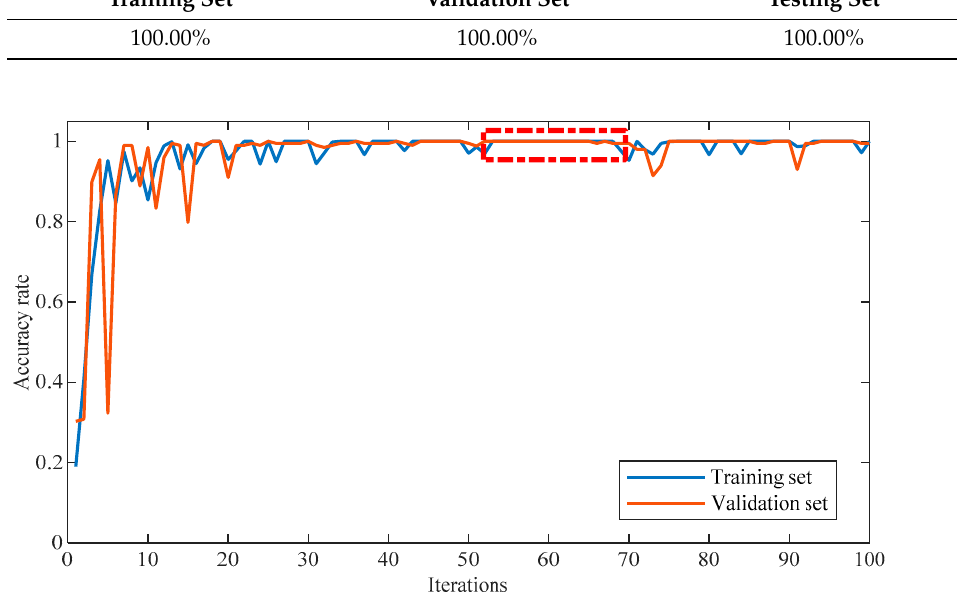
Figure 4. Identification accuracy rate curves of the training set and validation set.